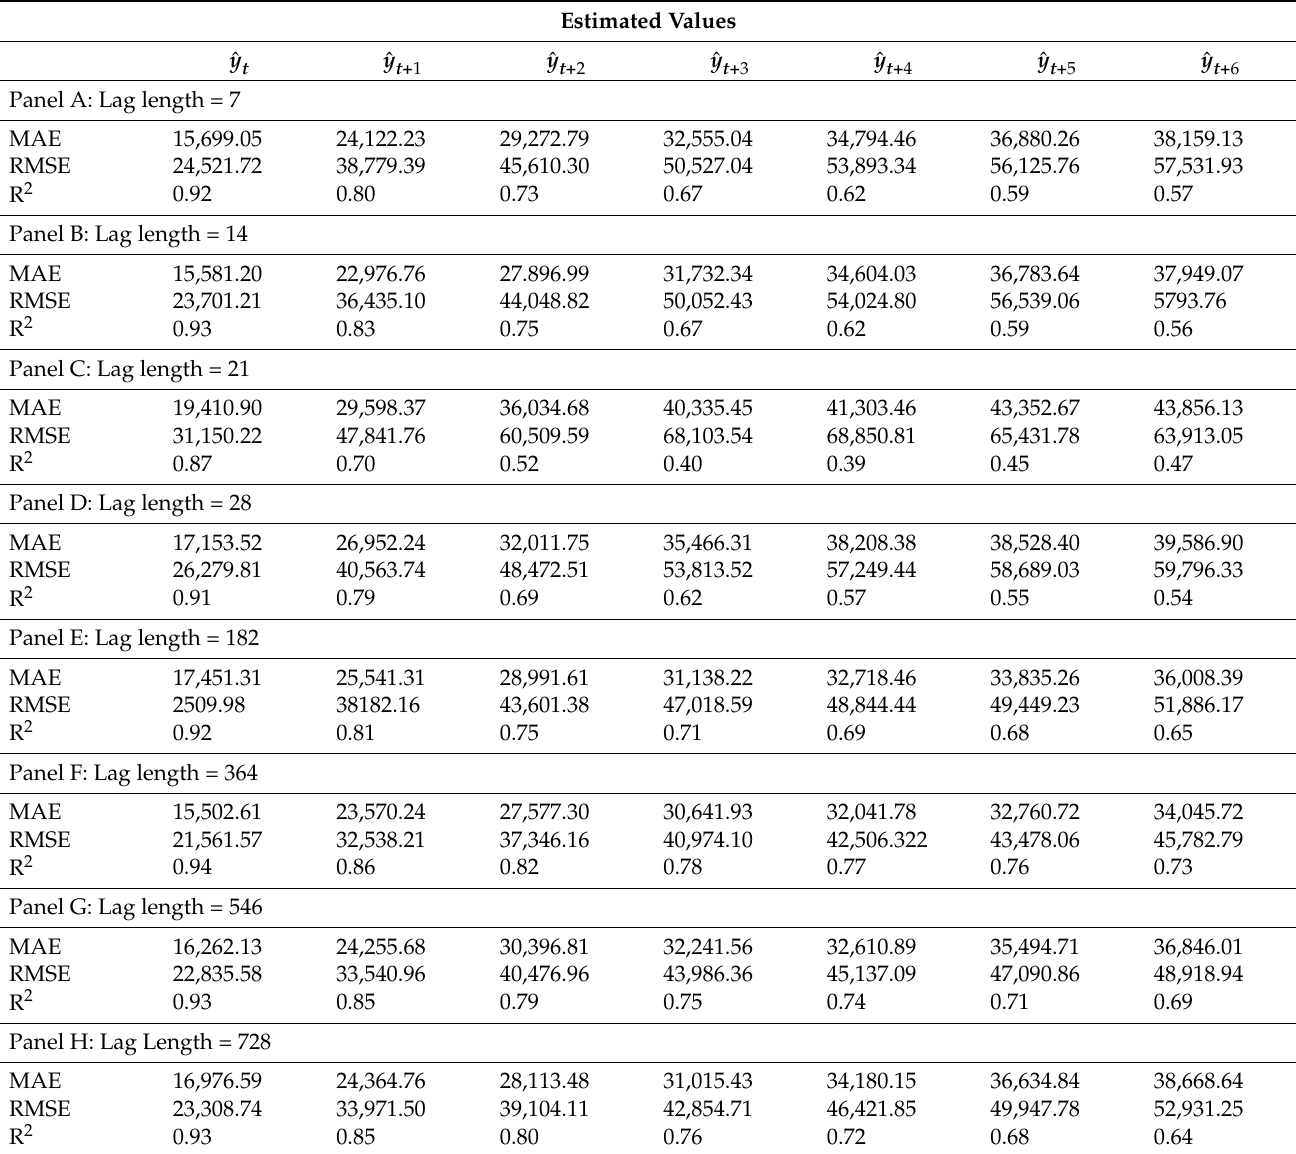
Table 3. Performance metrics of LSTM on train set for different lag size. Estimated